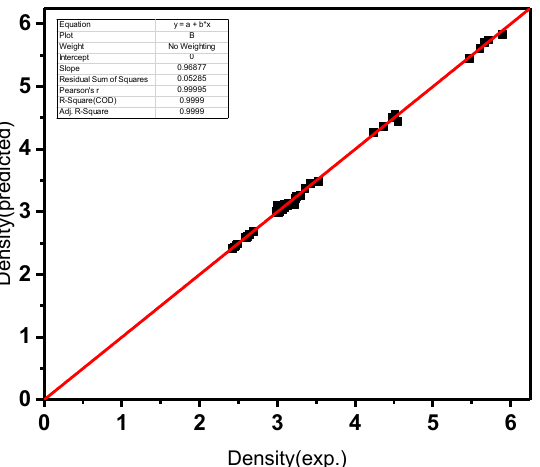
Figure 5. Experimentally measured density against predicted density utilizing ANN.